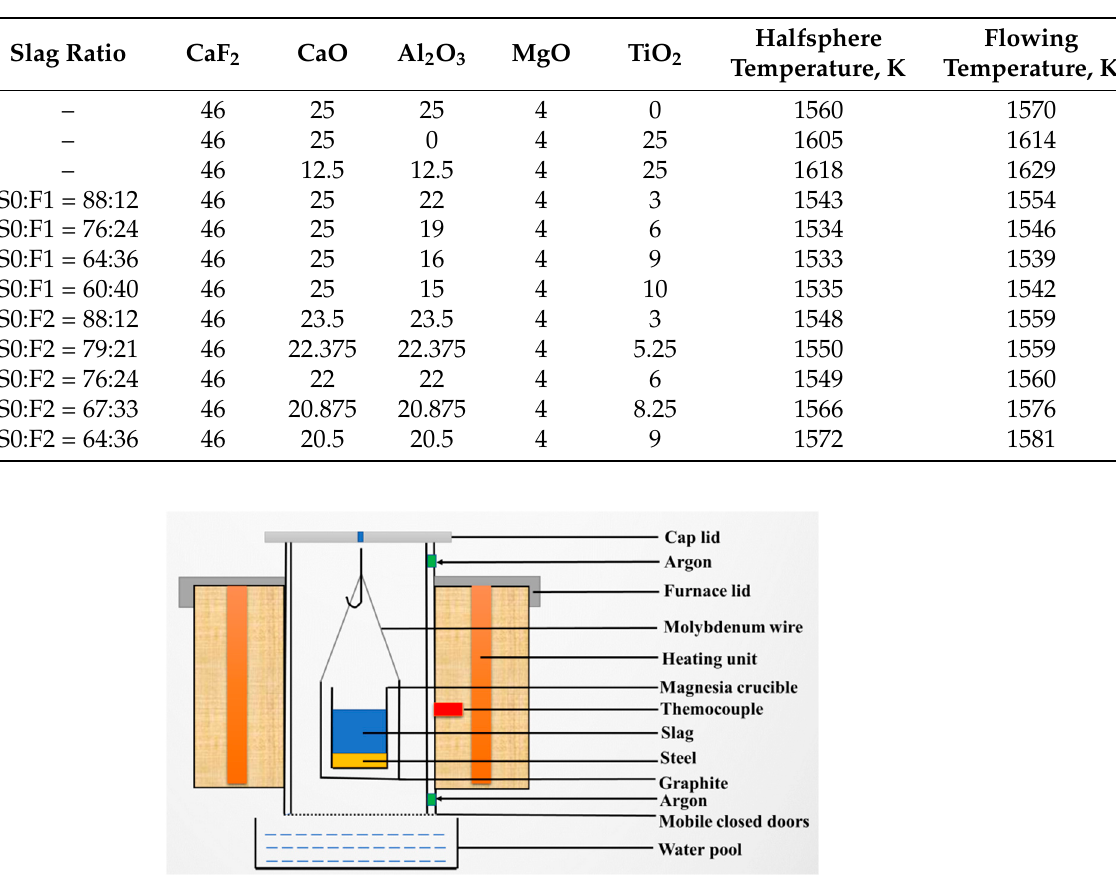
Figure 1. Schematic diagram of resistance furnace with function of dropping crucible from bottom. Table 1. Chemical composition of the SUS321 (Mass pct).